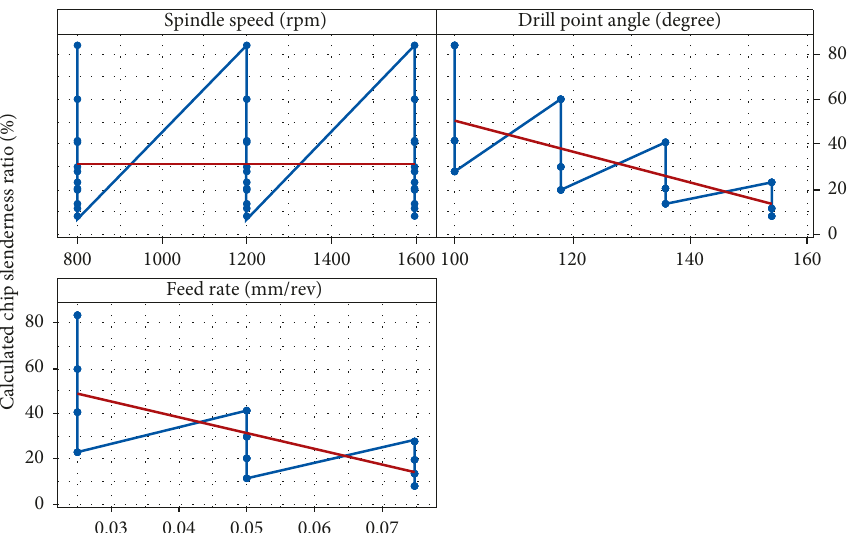
Figure 4: Effects of the selected parameters on the calculated chip slenderness